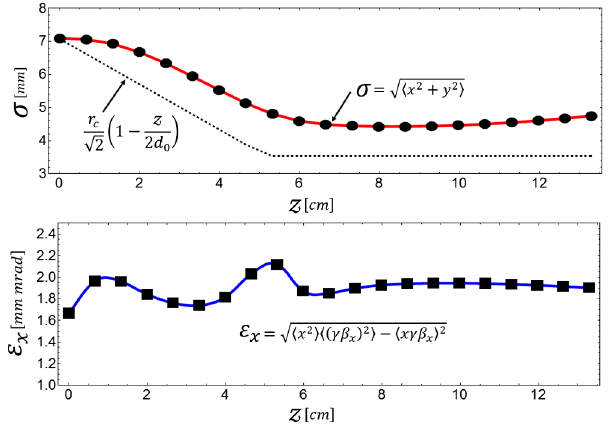
FIG. 9. CST simulation results for the variations of the rms beam radius (top panel) and the beam emittance (bottom panel) along the gun. For the rms beam radius also Eq. (12) is plotted (dashed